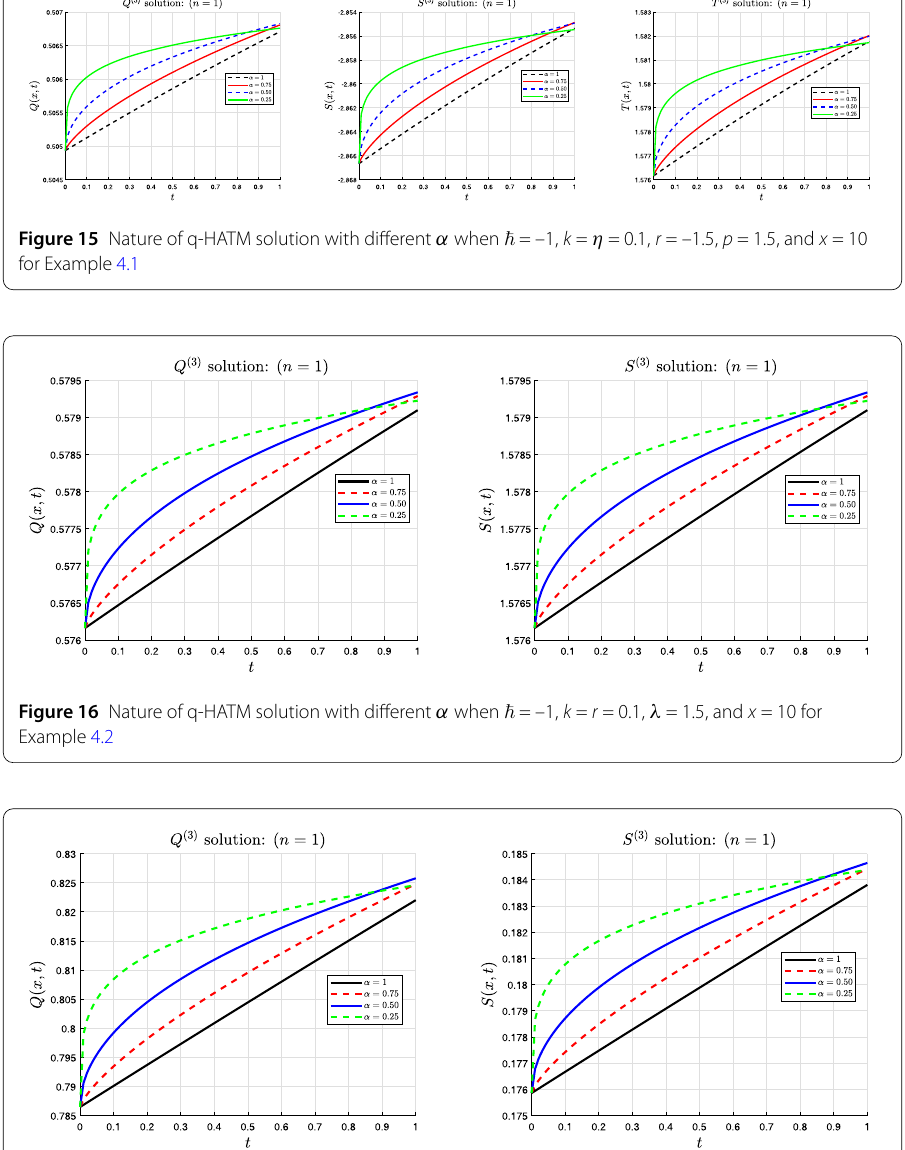
Figure 17 Nature of q-HATM solution with different α when (cid:2) = –1, A = r = 0.1, B = 3, and x = 1 for Example